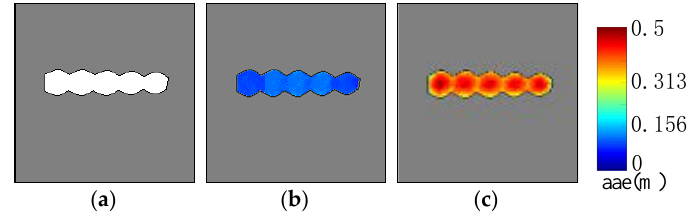
Figure 10. AGMs with different range error for virtual unambiguous environments: ( a ) Occupancy grid map of an unambiguous environment. ( b ) AGM with zero distance error. ( c ) AGM with 0.5 m distance error. The figure clearly shows that large distance error leads to large AAE value.